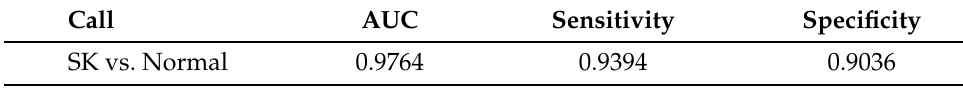
Table 7. Test scores for “SK vs. Normal” on the test set from Center 0.